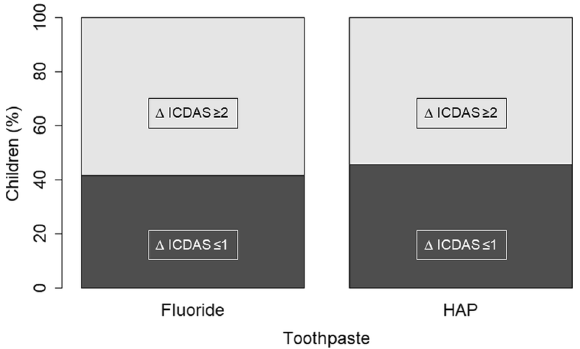
Figure 3. Increase in ICDAS ≥ ∆2 in the fluoride, and HAP-group. In both groups, the proportion of children who developed at least on one tooth a caries lesion of ICDAS ≥ ∆2 is not significantly different (more details are shown in Table 4).